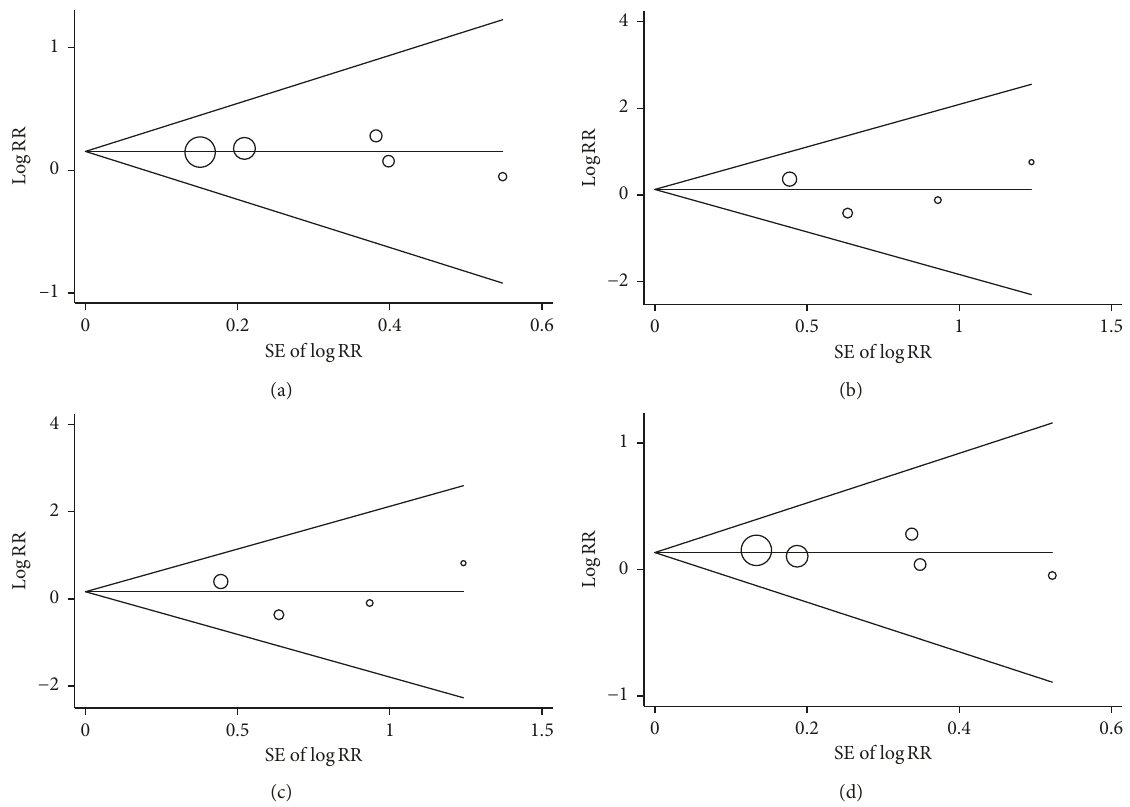
Figure 6: Begg’s funnel plot with pseudo 95% confidence limits for publication bias on MMP-9 − 1562 C > T, rs3918242 polymorphism and asthma susceptibility in the dominant model, recessive model, homozygote model, and allele model comparison. (a) Dominant model. (b) Recessive model. (c) Homozygote model. (d) Allele